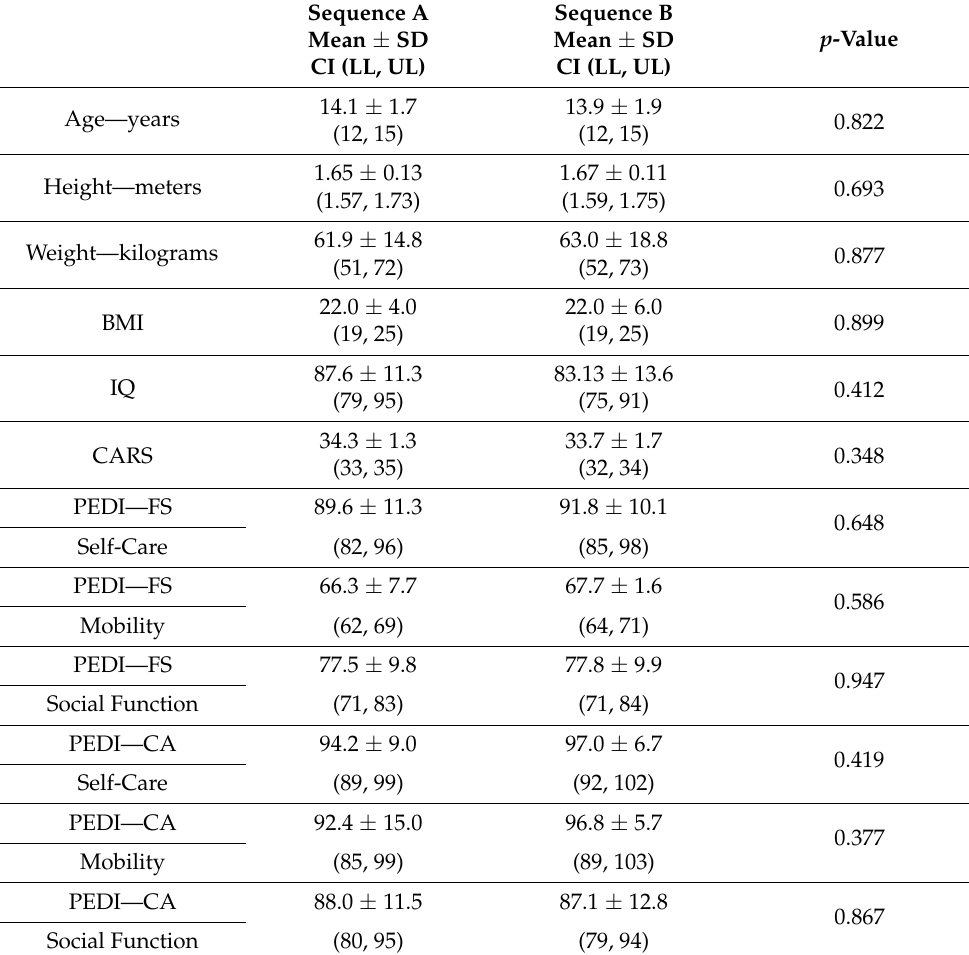
p -ValueMean ± SD Mean ± SD